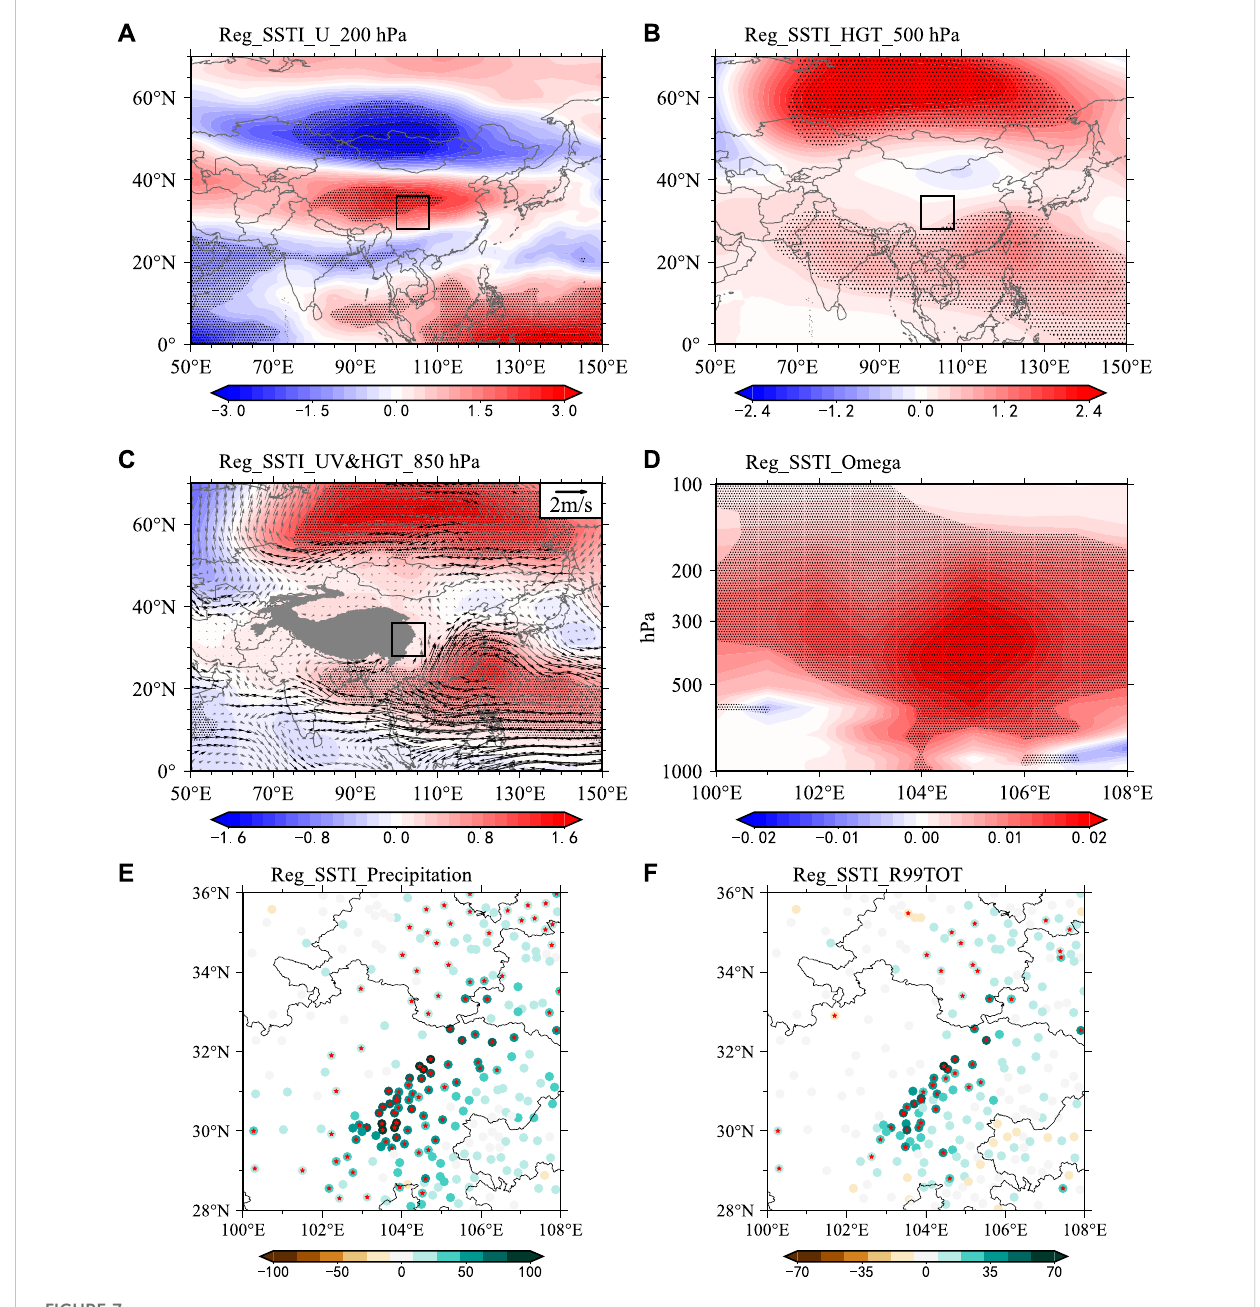
FIGURE 7 Regressed (A) zonalwindat200 hPa(Shading,Unit:m · s − 1 ), (B) geopotentialheightat500 hPa(Shading,Unit:gpm), (C) geopotentialheight(Shading, Unit: gpm) and wind fi elds (Vectors, Unit: m · s − 1 ) at 850hPa, (D) vertical velocity height-longitude pro fi le (Shading, Unit: m · s − 1 ), (E) later summer precipitation and (F) R99TOTin WC (Dots, Unit: mm) onto the SSTI from 1961 to 2021, respectively. Dotted areas and red starts are statistically signi fi cant at the 95% con fi dence